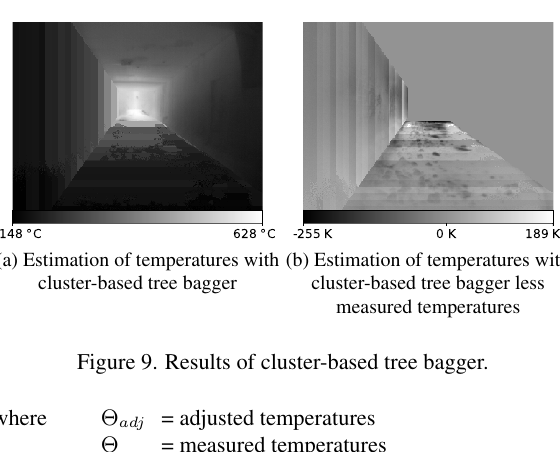
Figure 7. Results of cluster-based linear equation system.